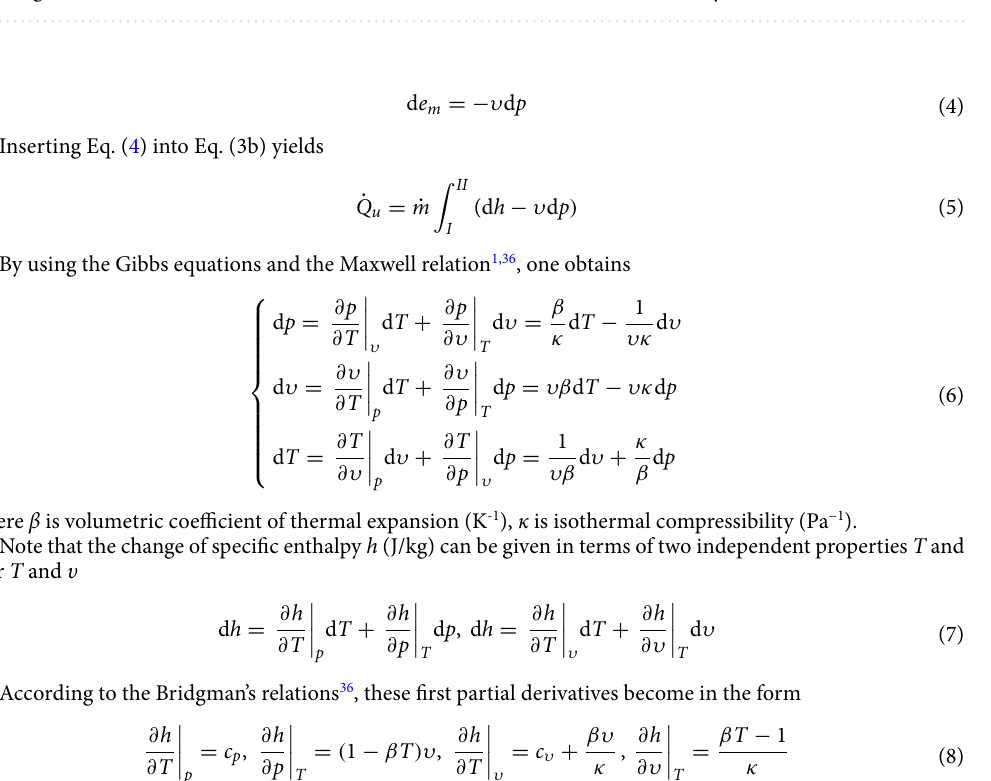
Figure 1. Sketch diagram of convection energy transfer. Control volume for steady compressible flow in a tube showing an advective heat transfer rate in a fluid-flow field in Cartesian coordinate